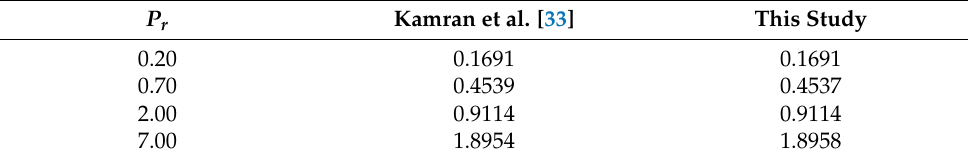
Table 4. Comparing − θ (cid:48) ( 0 ) values with P r , while φ = 0, β ξ = 0, Λ ξ , E ξ = 0, N ξ = 0, S h = 0 and H ξ → ∞